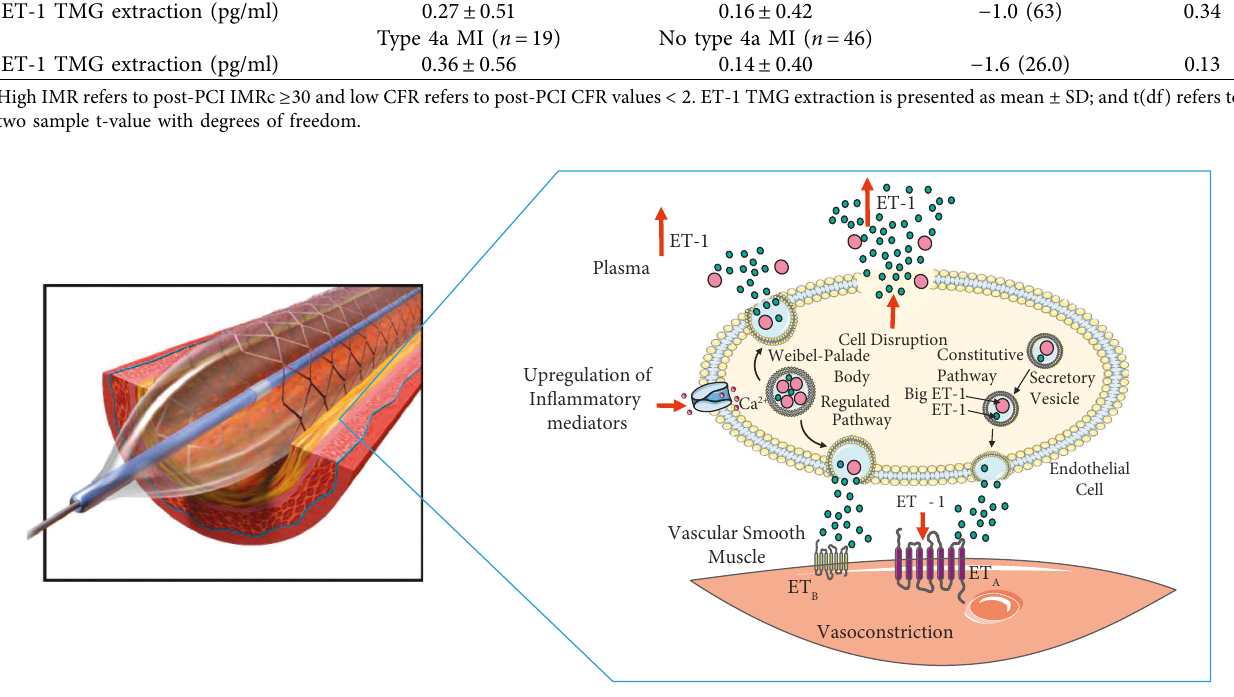
Figure 3: Suggested scheme for upregulation of ET-1 post-PCI. Mechanical disruption of atherosclerotic plaque and endothelial cells by balloon angioplasty leads to release of ET-1 and Big ET-1. Additionally, increased circulating inflammatory mediators post-PCI may upregulate the regulated Weibel–Palade Body secretory pathway. ET-1 binds to ETA receptors on vascular smooth muscle cells causing vasoconstriction. Figure incorporates material derived from angioplasty: balloon inflated with stent by Blausen Medical used under license: CC BY-SA 4.0 and Servier Medical Art (smart.servier.com) used under License CC BY